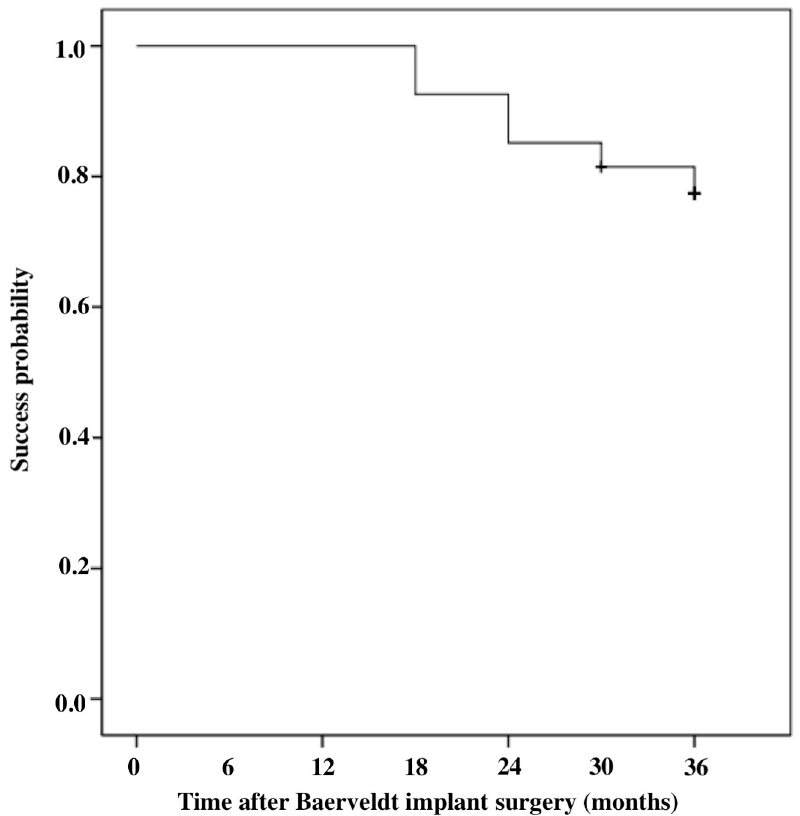
Fig 4. Kaplan-Meier survival analysis of surgical